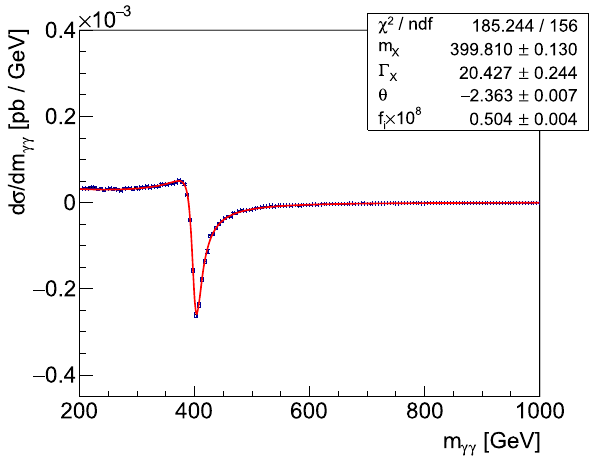
Fig. 4 A fit of the analytic description of the interference between the benchmark signal model and the SM background to a MC sample of interference-only